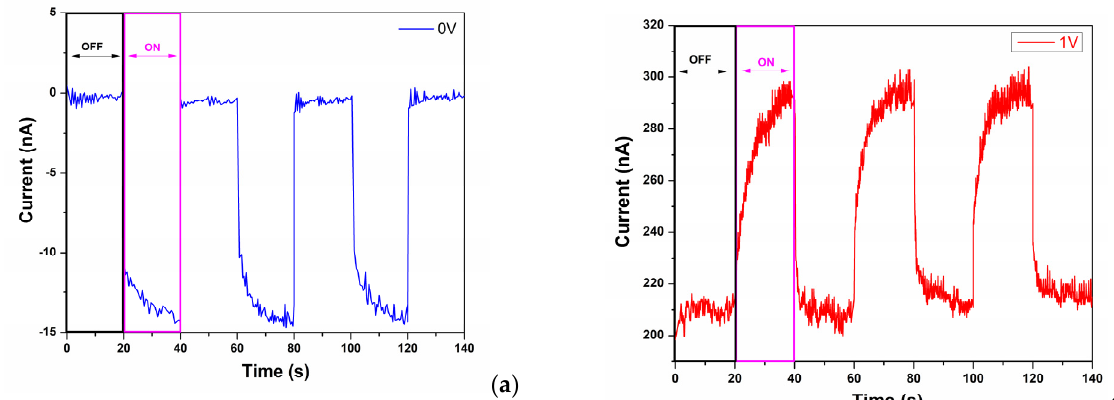
Figure 7. UV time-dependent photoresponse properties of the sensors. ( a ) Response of the sensor in self-powered mode; ( b ) UV response of the sensor at 1 V bias voltage.